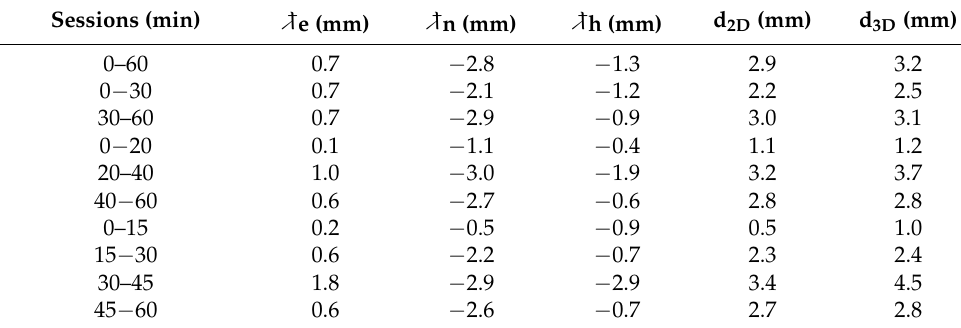
Table 4. Positioning performance results at ST 1.